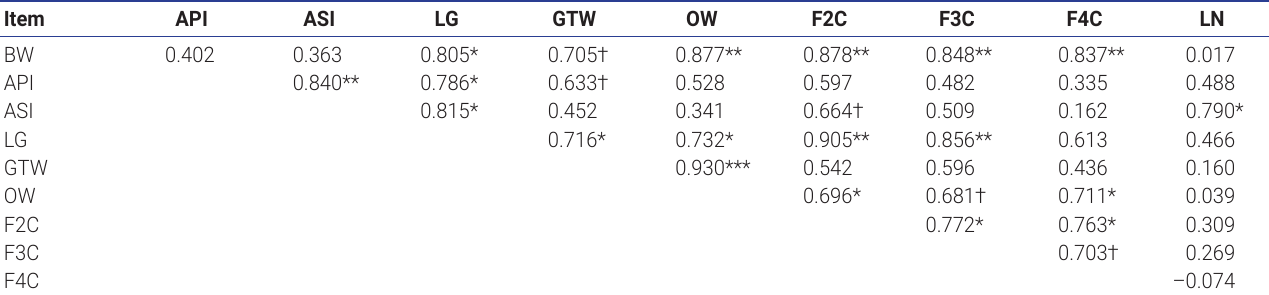
Table 4. Partial correlation coefficients among abdominal profile score and abdominal sagging index and reproduction system in